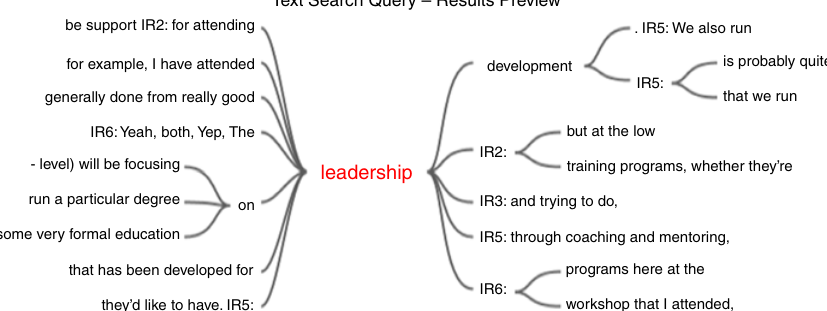
Figure 1. Text search